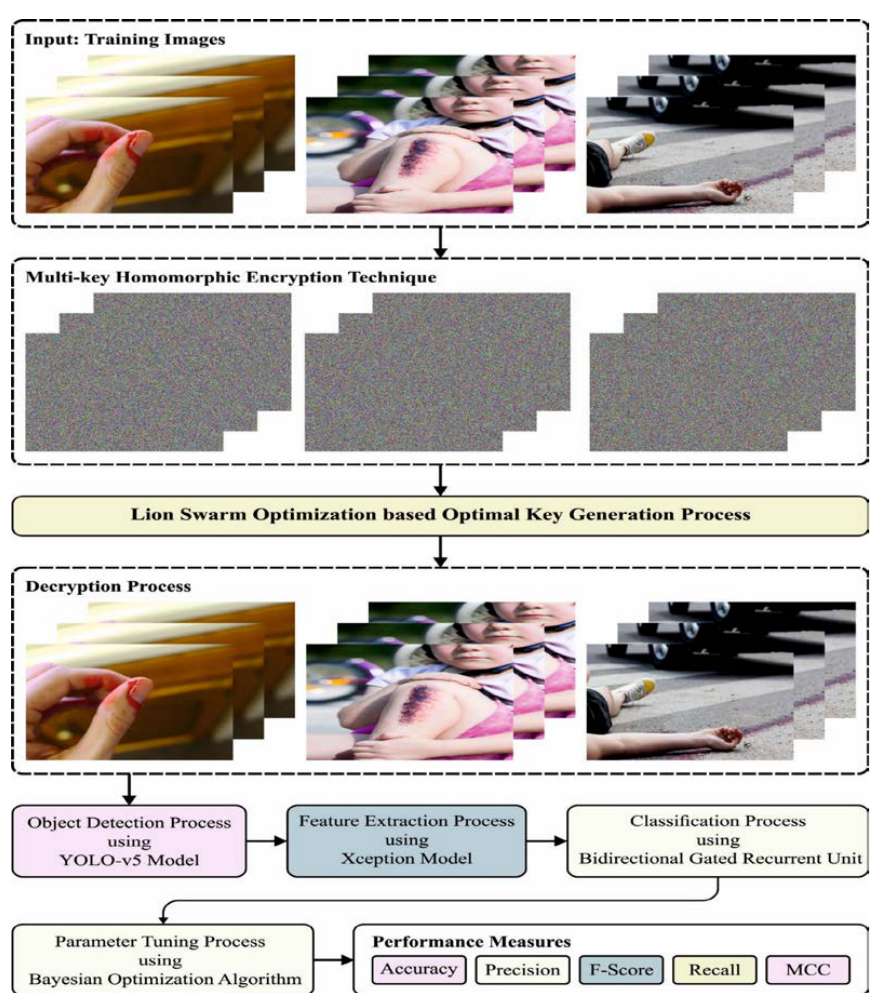
Figure 1. Block diagram of PPIE-ODLASC system.